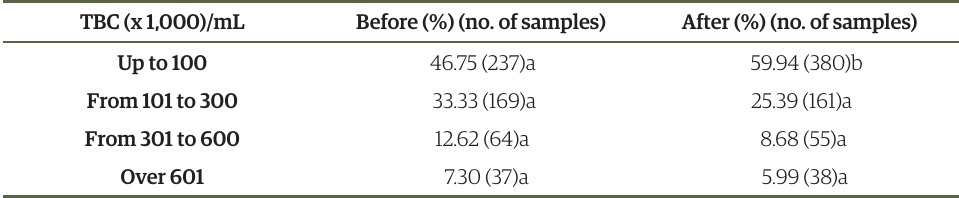
table 2. Total bacterial Count (TBC) of milk of 106 herds in Alagoas before and after application of Good Manufacturing Practices to milking from November, 2010 to May, 2012.